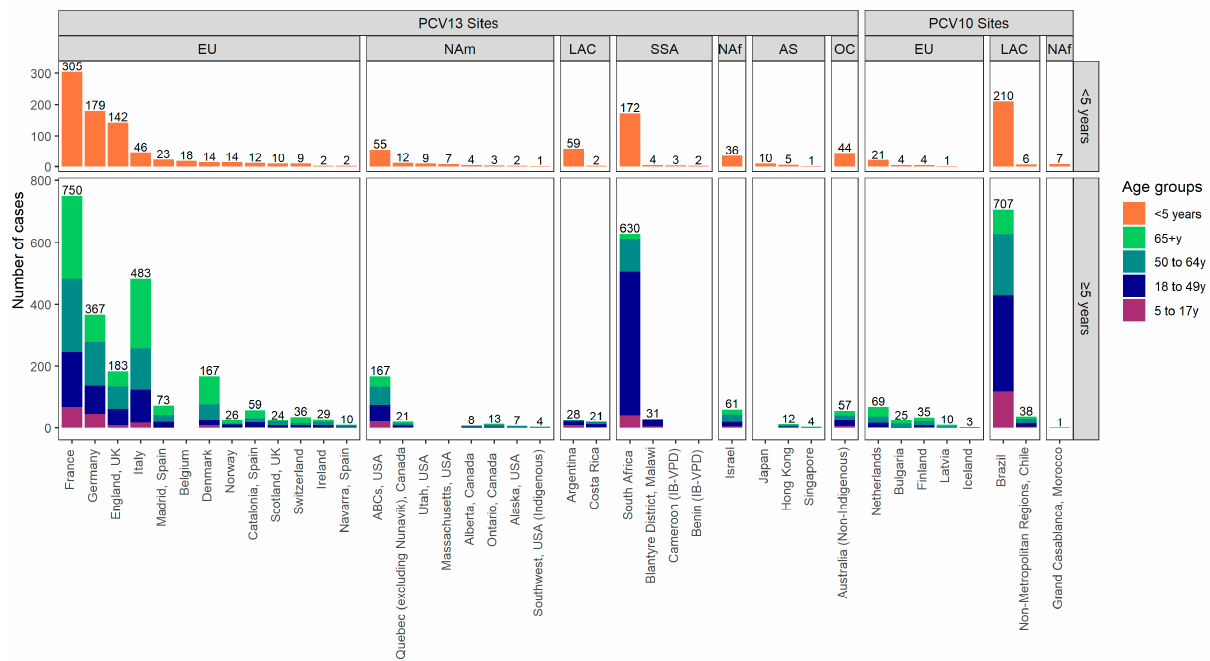
Figure 1. Number of serotyped cerebrospinal fluid positive (CSF+) pneumococcal meningitis cases per site in mature PCV10/13 years by UN region, pneumococcal conjugate vaccine (PCV) product used during years included in the analysis, and age group. Abbreviations: EU = Europe, NAm = North America, LAC = Latin America and Caribbean, SSA = Sub- Saharan Africa, NAf = Northern Africa and Western Asia, AS = Asia, OC = Oceania. PCV13 is Pfizer’s Prevnar13/Prevenar13; PCV10 is GSK’s Synflorix.